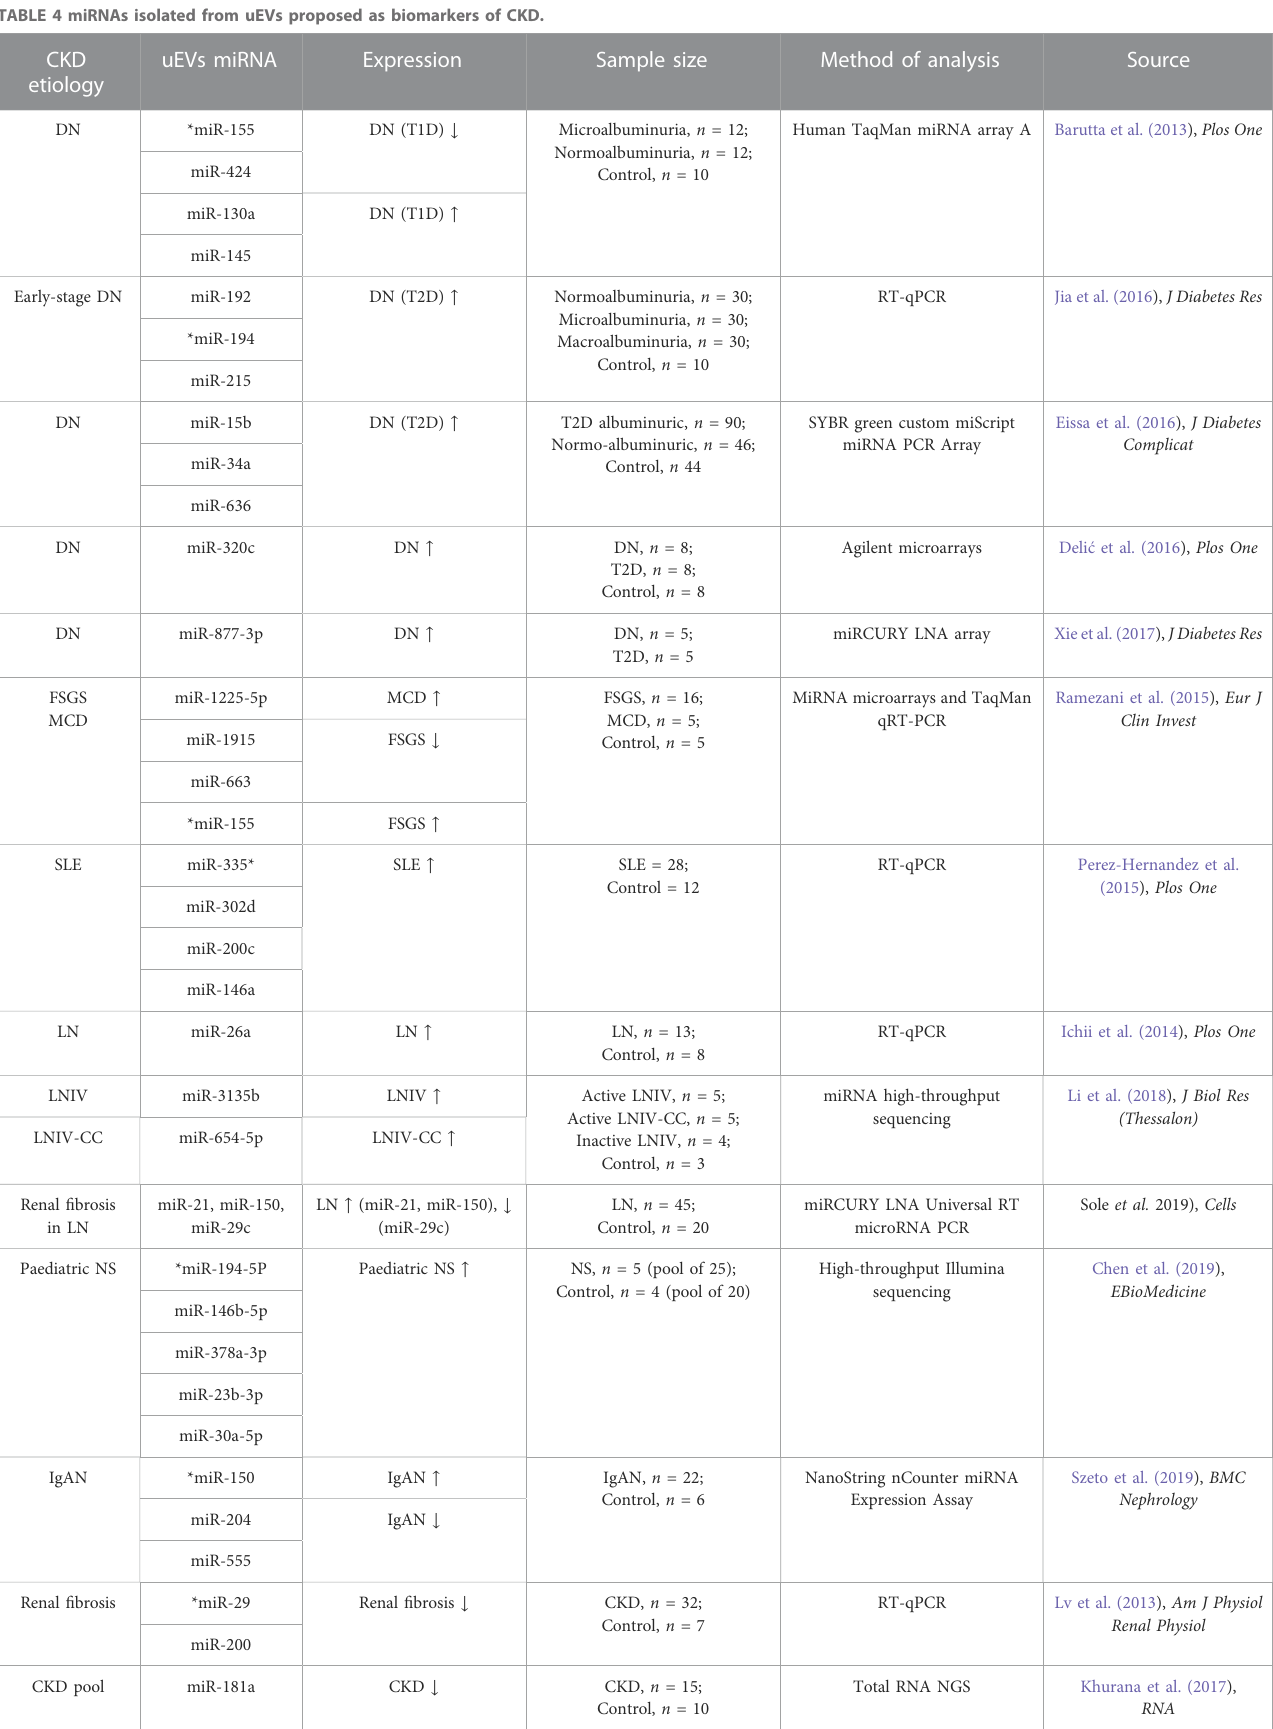
TABLE 4 miRNAs isolated from uEVs proposed as biomarkers of